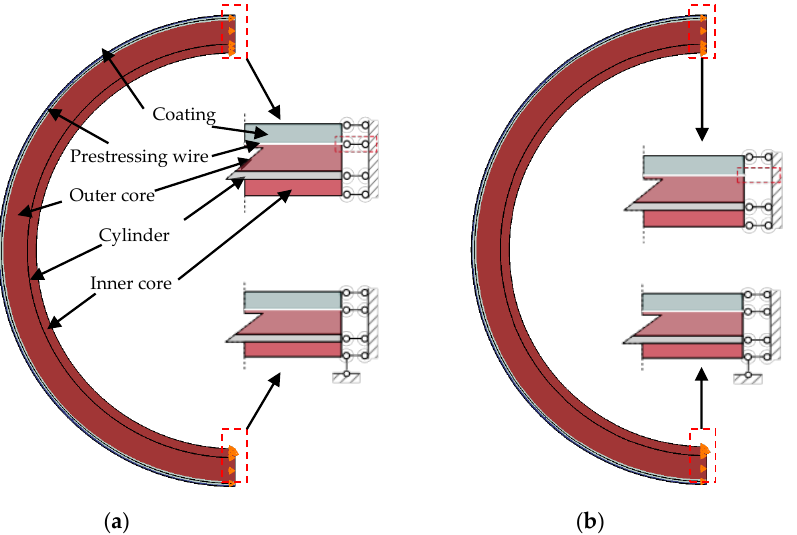
Figure 8. Boundary conditions for the FE model: ( a ) before wire breaks and ( b ) after wire breaks.